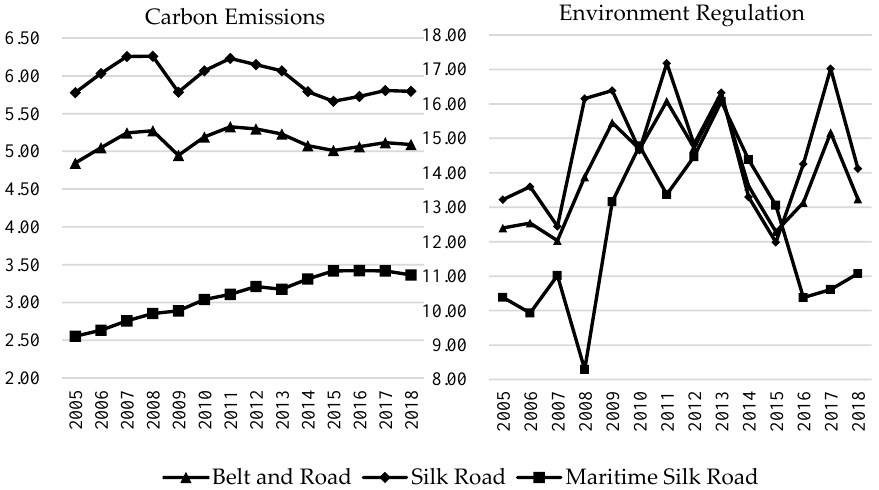
Figure 1. The situation of carbon emissions and environmental regulation of countries along the Belt and Road.